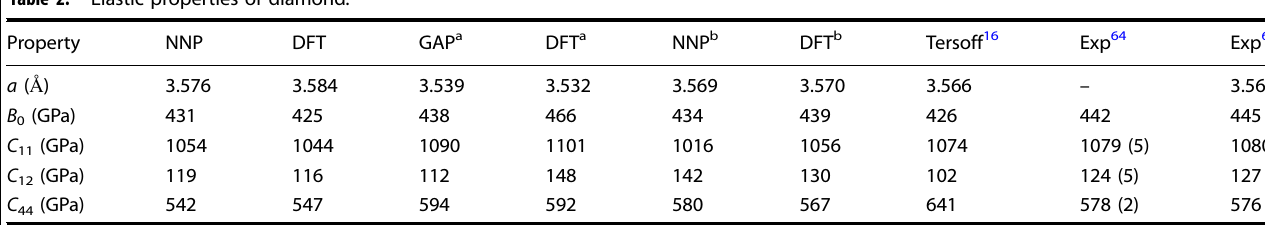
Fig. 3 Prediction of energy ordering of carbon structures. The energy ordering predicted by NNP is compared to DFT and other models for 197 distinct carbon structures reported in ref. 35 . a Prediction performance of NNP at different iterations of the self- consistent cycle visible improves. b Prediction performance of GAP 21 , reactive force fi eld (ReaxFF) 75 and Tersoff 16 models is reported alongside the fi nal NNP model (blue line). For comparison, we train a new model with LDA exchange-correlation functional, named as NNP-LDA (red line). The neural network potentials for the two functionals overlap for the majority of the structures, as do the DFT results (see the Supplementary Fig. 4). Further analysis of prediction error in energy (instead of ranking) and the analysis of similarity between this dataset and the one used in NNP generation is reported in Supplementary Fig. 5. Table 2. Elastic properties of